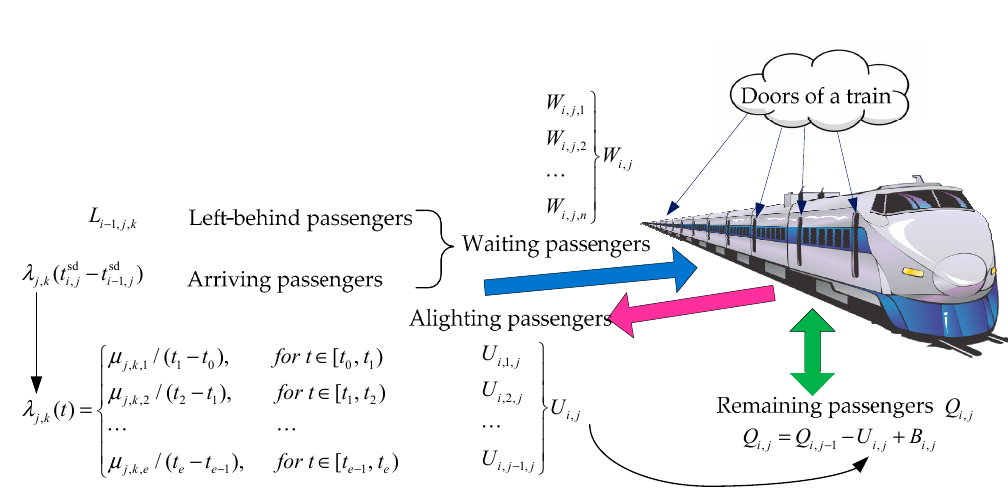
Figure 4. Illustration of passengers’ activity information when using a metro train.